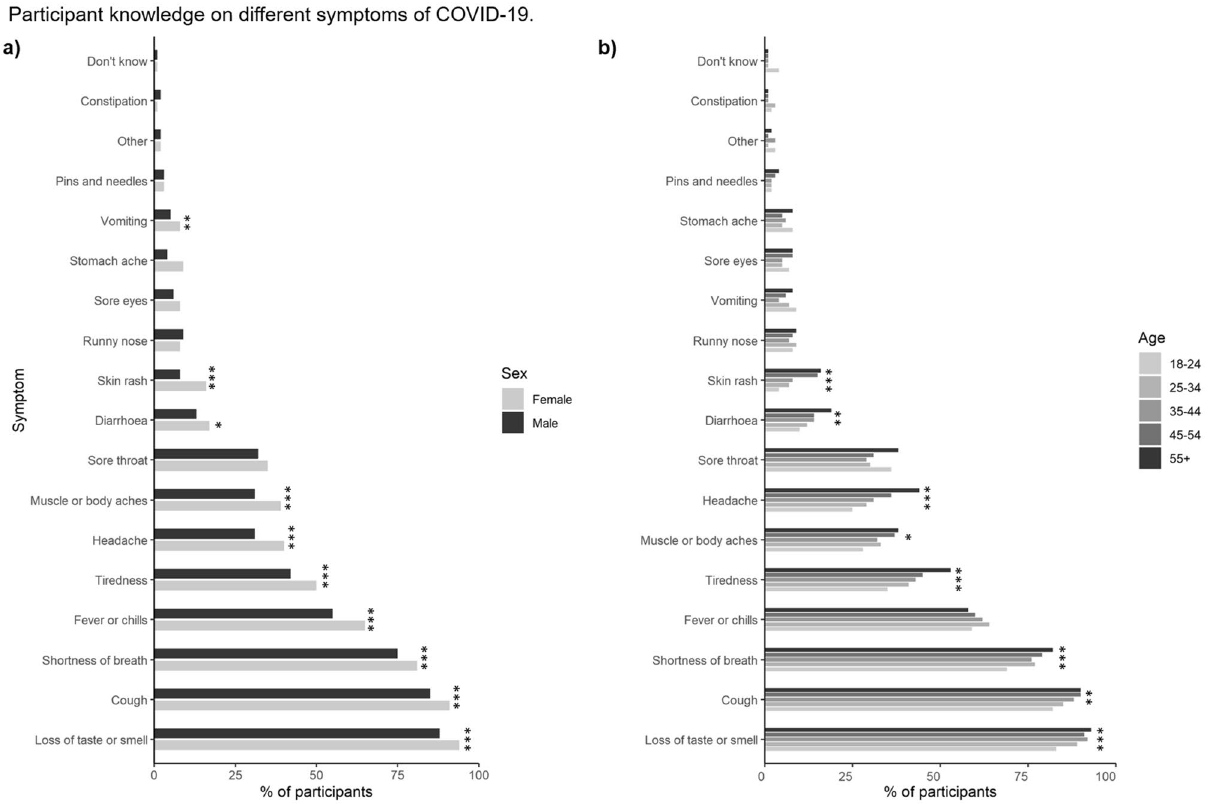
Figure 1. Proportion of participants stratified by either ( a ) gender, or ( b ) age ( n = 2103). *, **, and *** represent significant differences between the gender or age categories for a particular symptom at the P < 0.05, P < 0.01 or P < 0.001 level,